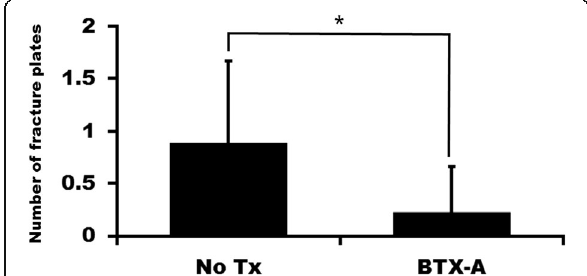
Fig. 2 Number of fractured plates in each group (No Tx: no